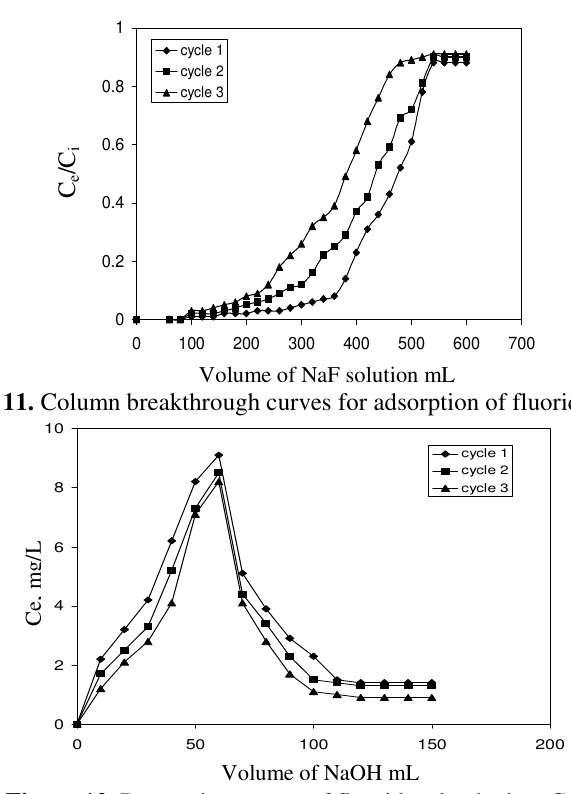
Figure 12. Desorption curves of fluoride adsorbed on